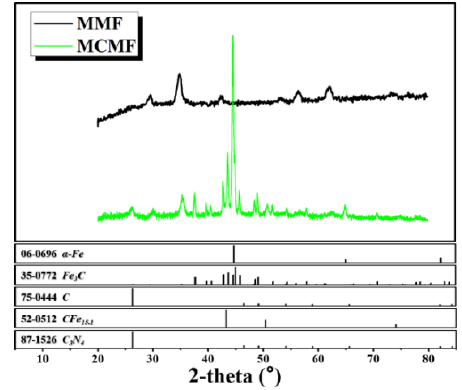
Figure 2. XRD curves of magnetic MF foam (MMF) (black) and MCMF (green), respectively.